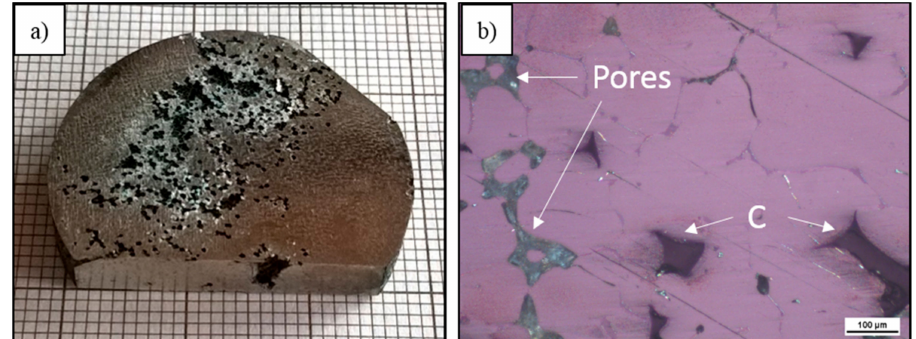
Figure 3. ( a ) Macrograph and ( b ) LM micrograph of C of –AZ31 composite obtained by pressure infiltration.